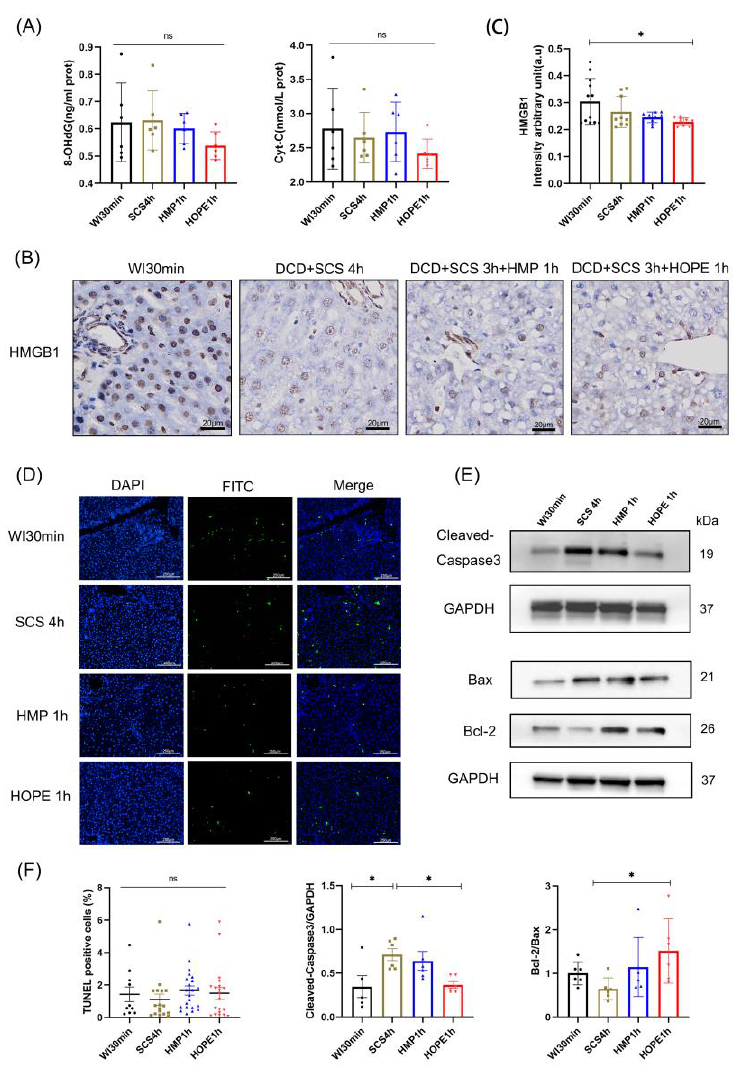
Figure 4. Nuclear damage and apoptosis induced by hypoxia-ischemic injury. ( A ) Enzyme-linked immunosorbent assay (ELISA) kit of 8-OHdG and Cyt C in liver tissue. ( B ) IHC staining of HMGB1 was performed on the paraffin-embedded section of rat liver tissues. Scale bar: 20 µ m; ( C ) IHC-stained HMGB1 were quantified using Image J. ( D ) Apoptotic cells were evaluated using the TUNEL assay, and the number of apoptotic cells was counted. Scale bar: 250 µ m; ( E ) Western blot shows the apoptosis-related protein level in four different groups; ( F ) TUNEL-positive cells and quantitative analysis of the relative intensity of Cleaved-Caspase 3, Bax, and Bcl-2 normalized to the GAPDH loading control were quantified using Image J ( n = 6 per group for ( A ); n = 3 independent experiments for ( B – E )). Mean ± SD, N.S., p > 0.05, * p < 0.05.